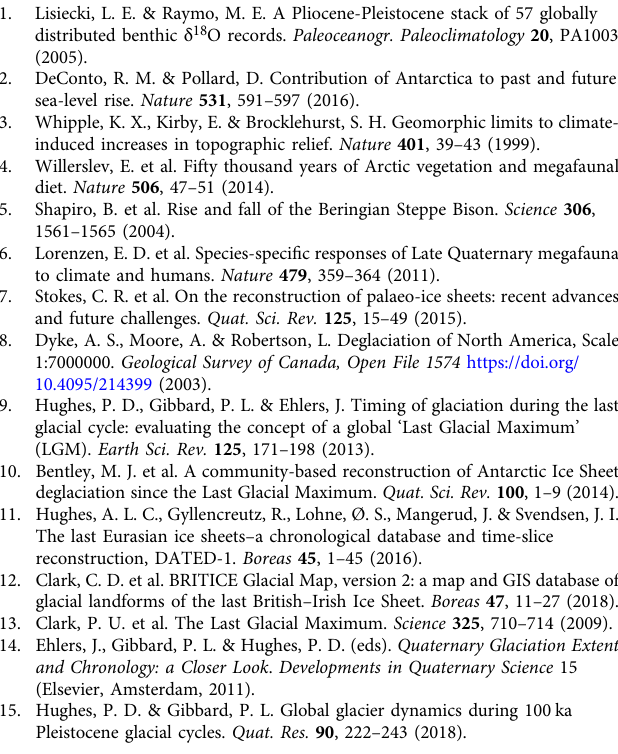
Tables 1 – 17. Shape fi les of our reconstructions, as well as the digitised and georeferenced empirical and modelled data, are available on the Open Science Framework [https://osf.